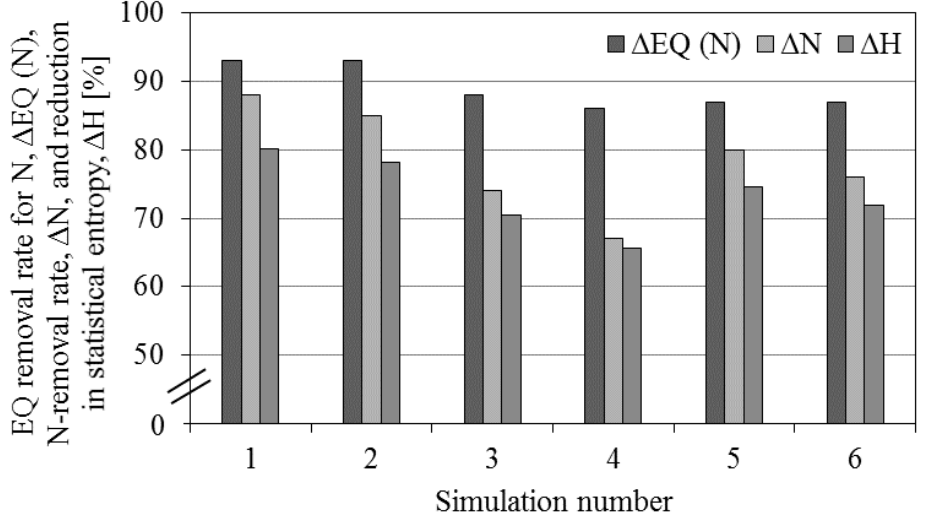
Figure 2. EQ removal rate for N ( Δ EQ performance according to eSEA ( Δ H) for all WWT simulations.